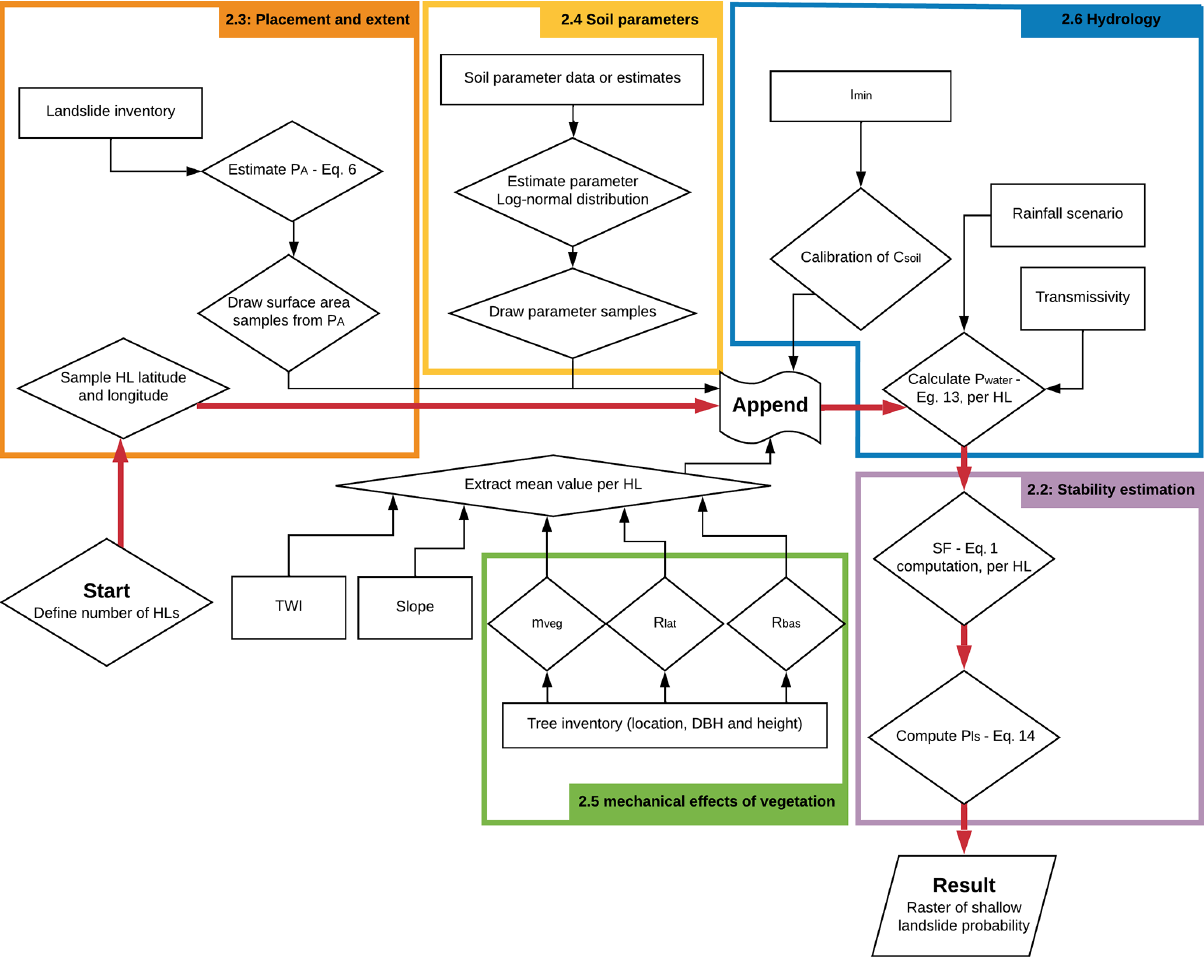
Figure 1. Flow chart of the computational steps in SlideforMAP. Separate sections are outlined in colours. The central workflow is high-